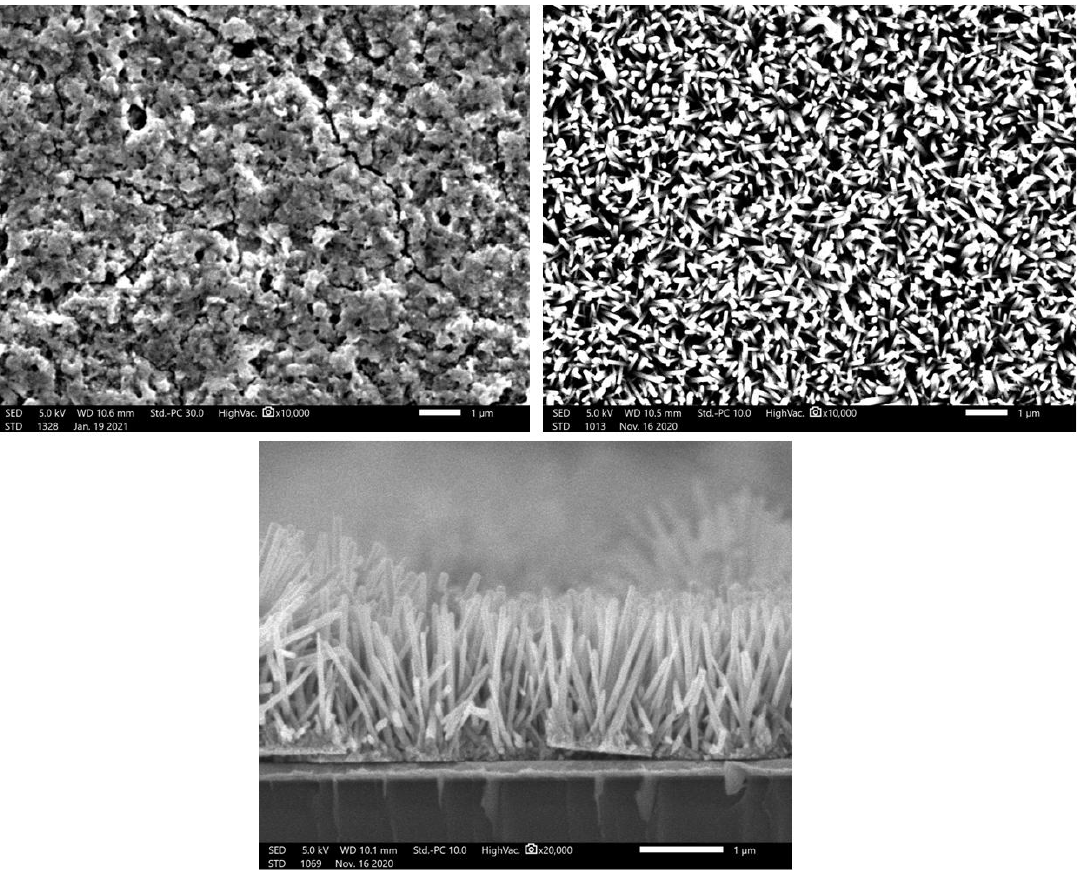
Figure 7. Top-view SEM image of ZnO Seed layer and ZnO nanorods grown at 90 °C for 24 h on stainless steel substrate. The SEM image at the bottom is the cross-sectional view of ZnO nanorods grown on ZnO seeded silicon substrate for 24 h. Table 1. Average diameter and length of ZnO NRs grown for 3 h, 6 h, 12 h and 24 h.